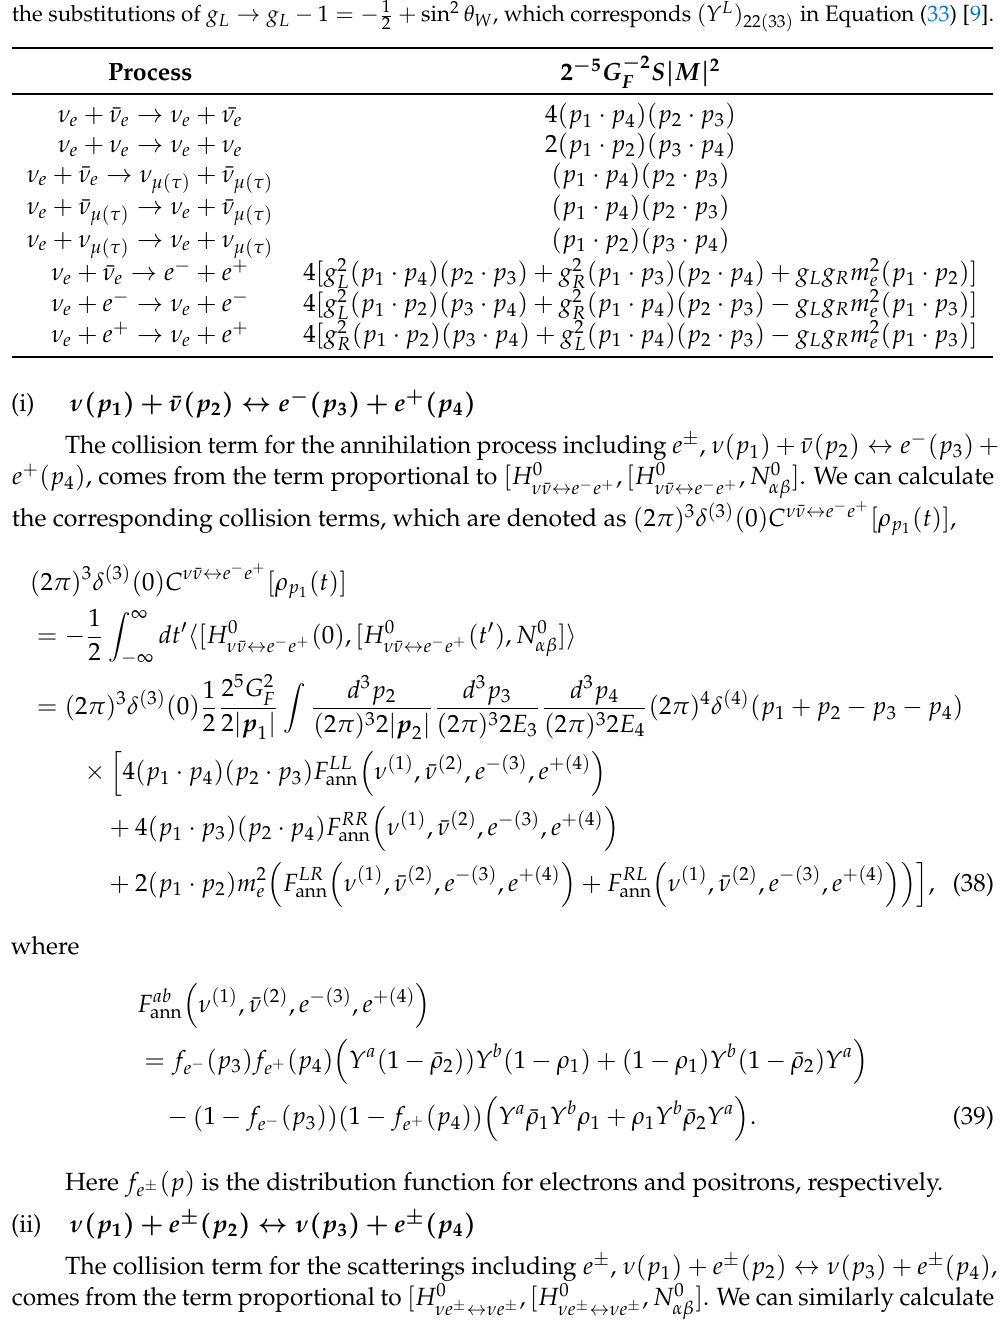
Table 1. Squared matrix elements with the symmetric factor S | M | 2 for processes ν e ( p 1 ) + b ( p 2 ) → + sin 2 θ 2 c ( p 3 )+ d ( p 4 ) . g L = 1 and g R = sin 2 θ W correspond ( Y L ) 11 and ( Y R ) 11 in Equation (33). For W 2 processes of ν µ and ν τ , ν µ ( τ ) ( p 1 ) + b ( p 2 ) → c ( p 3 ) + d ( p 4 ) , squared matrix elements are obtained